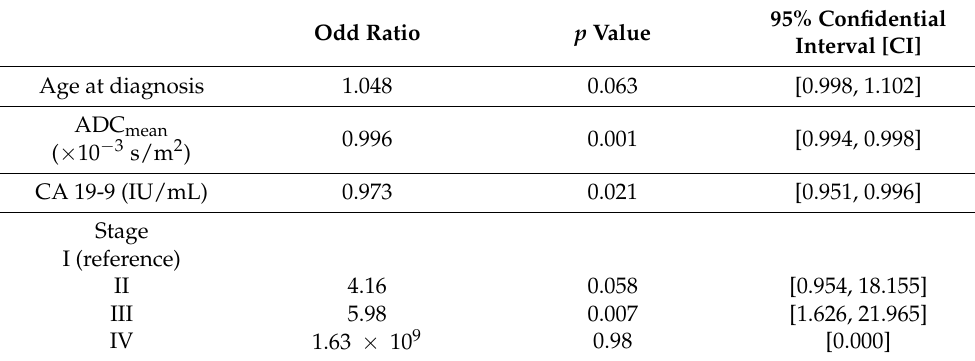
Table 2. Multivariate logistic regression of HGSOC.